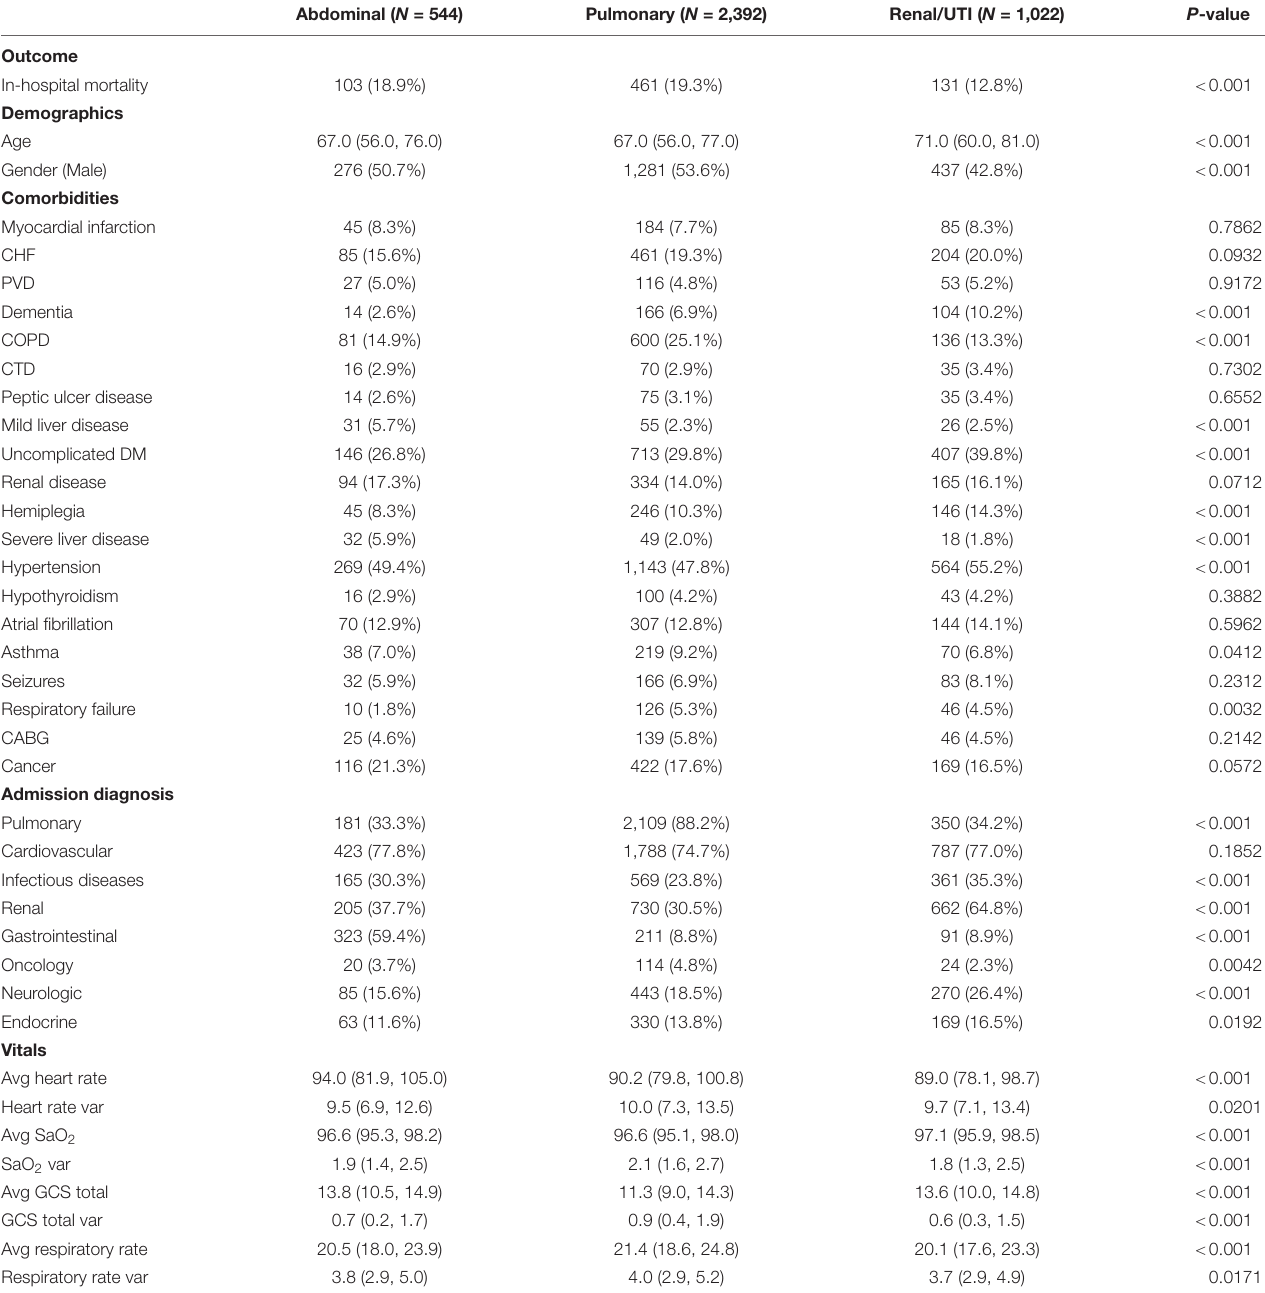
TABLE 1 | Demographics, comorbidities, vital signs, and routine prognostic scores used for